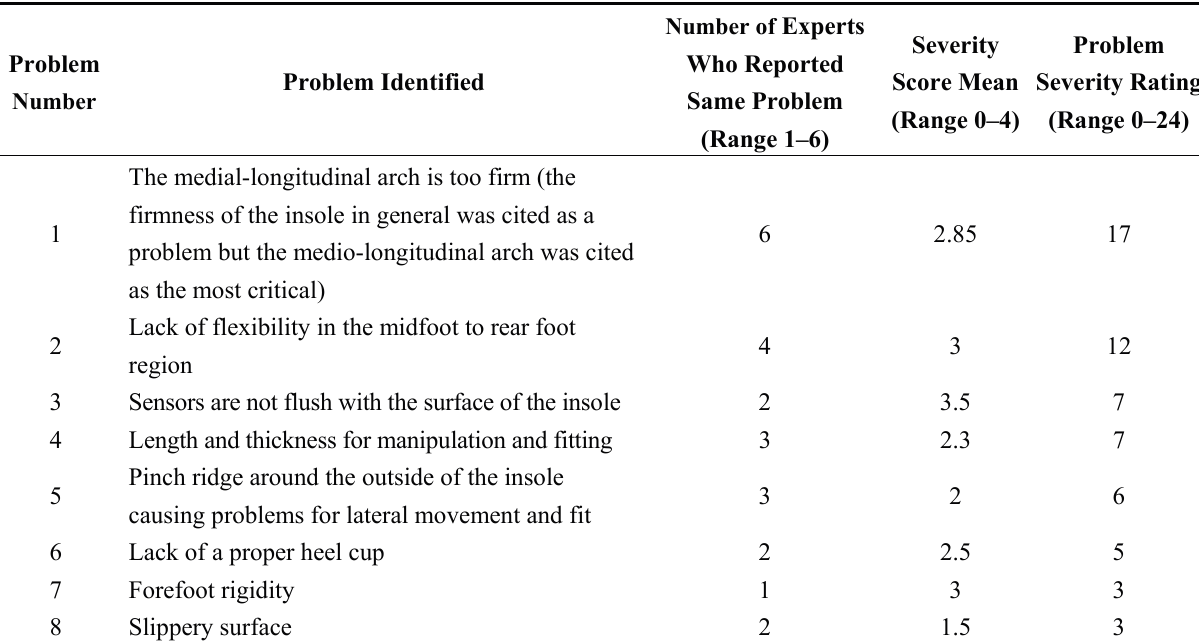
Table 6. Problems ordered in terms of a weighted aggregate of frequency reported and severity